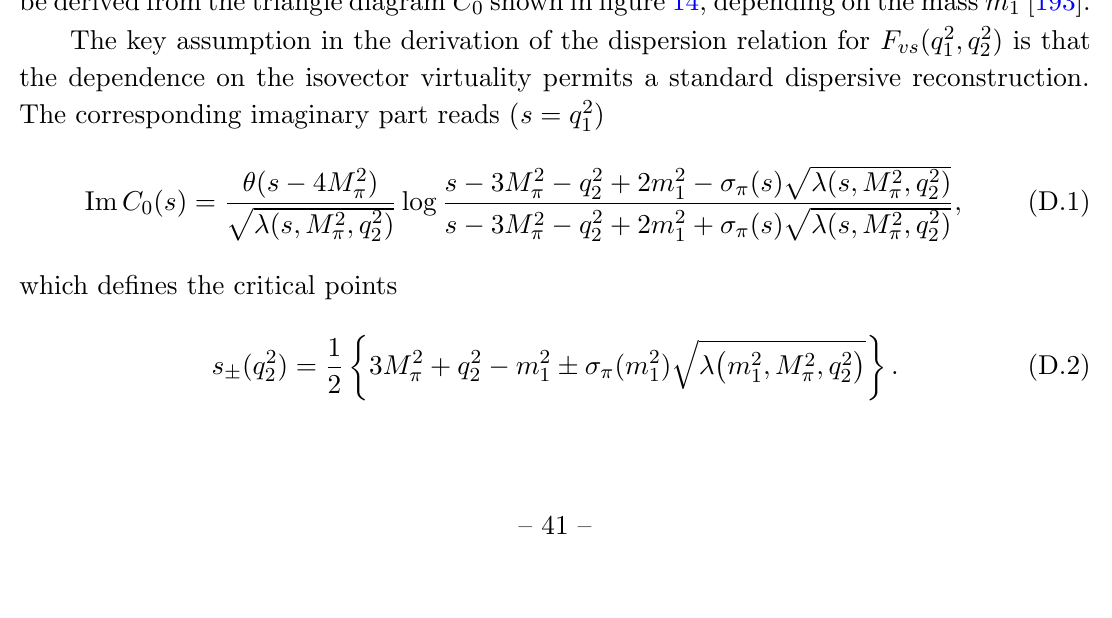
Figure 14. Triangle topology in the (cid:25) 0 anomalous thresholds